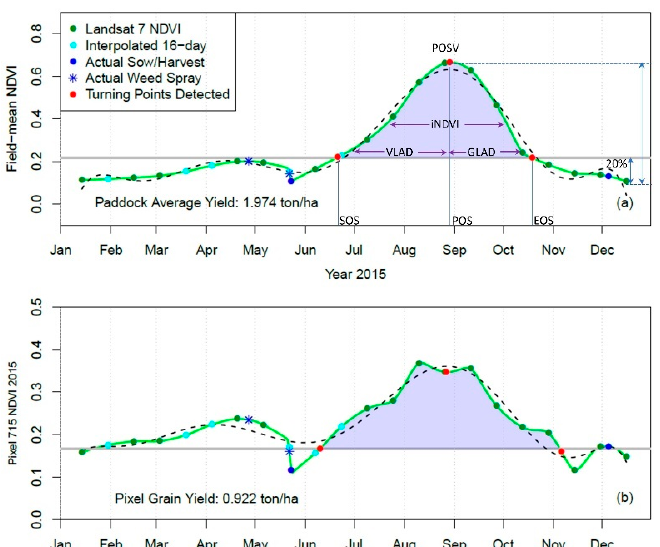
Figure 2. Examples for field J in year 2015 of the statistical phenology detection model (SPD): ( a ) for field average, and ( b ) for a pixel. The green solid line shows the ‘reconstructed daily’ NDVI sequence. The black dashed line shows the fitted polynomial curve. The grey horizontal line shows the 20% threshold of the daily NDVI amplitude used to identify the start of season (SOS) and end of season (EOS) dates. POSV, iNDVI, VLAD, and GLAD are integrated NDVI metrics that measure different parts of the area under the ‘reconstructed daily’ curve.